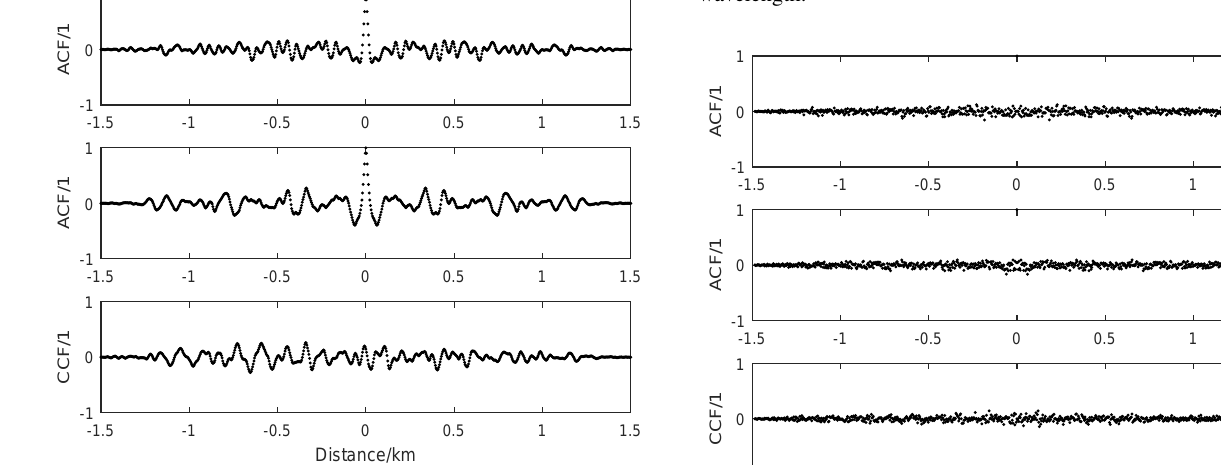
Figure 5. Transformed residual deviations for (parts of) the mea- sured signals shown in Fig. 1 obtained using a multi-output auto- regressive model of order four for the residual deviations shown in Fig. 3: (left) at off-resonant wavelength and (right) at on-resonant wavelength.